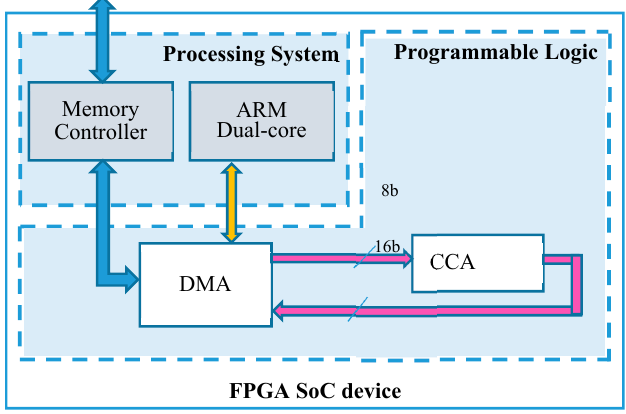
Figure 12. Integrating the proposed CCA accelerator within modern heterogeneous FPGA-based SoCs. Table 1. Characteristics of the proposed CCA implementation and other state-of-the-art designs.